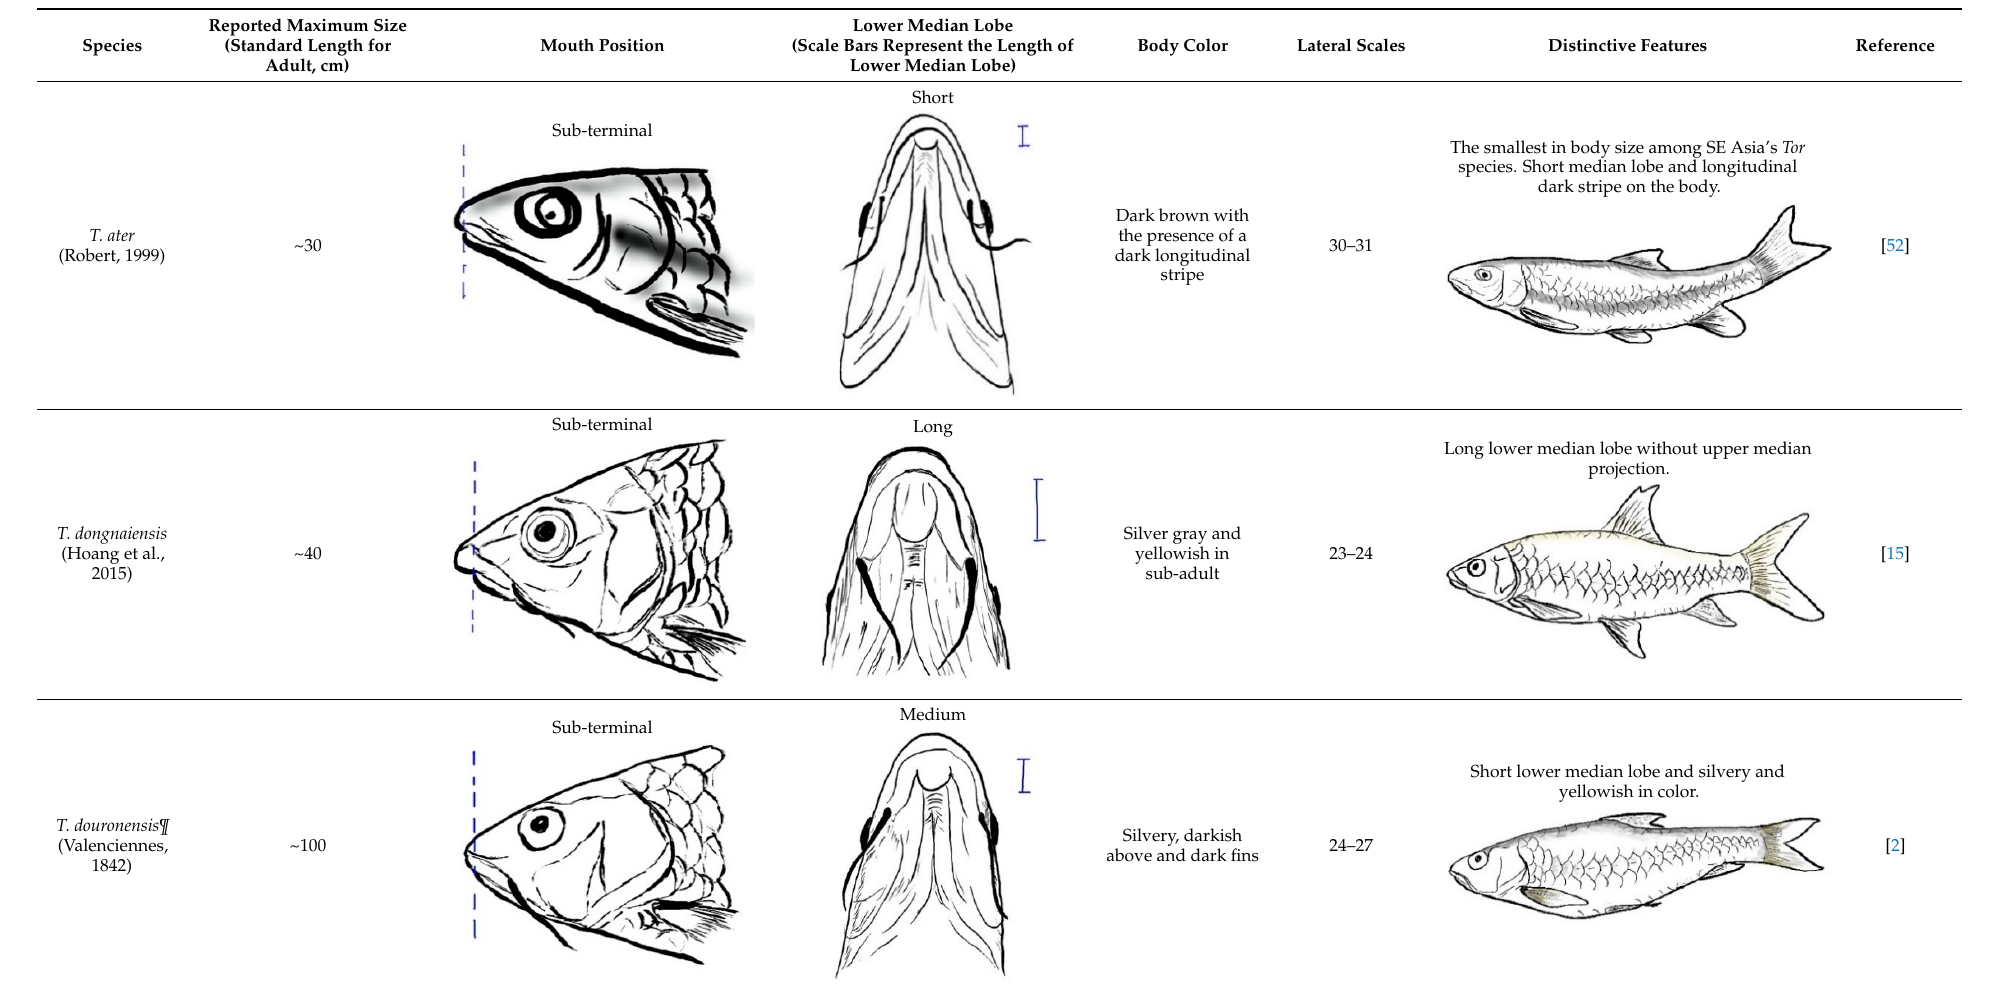
Table 3. The morphological features of SE Asia’s Tor species. The figures in this table were drawn based on an actual sample of fish, descriptions recorded, or redrawn from photos: T. ater [36] ; T. dongnaiensis [15] ; T. douronensis [87] ; T. laterivittatus [88] ; T. mekongensis [15] ; T. mosal [89] ; T. putitora [89] ; T. sinensis [15] ; T. tambra [13] ; T. tambroides, our picture and [90] ; T. tor [89] ; T. yingjiangensis [28] . Note: ¶ symbol is represent uncertain species.